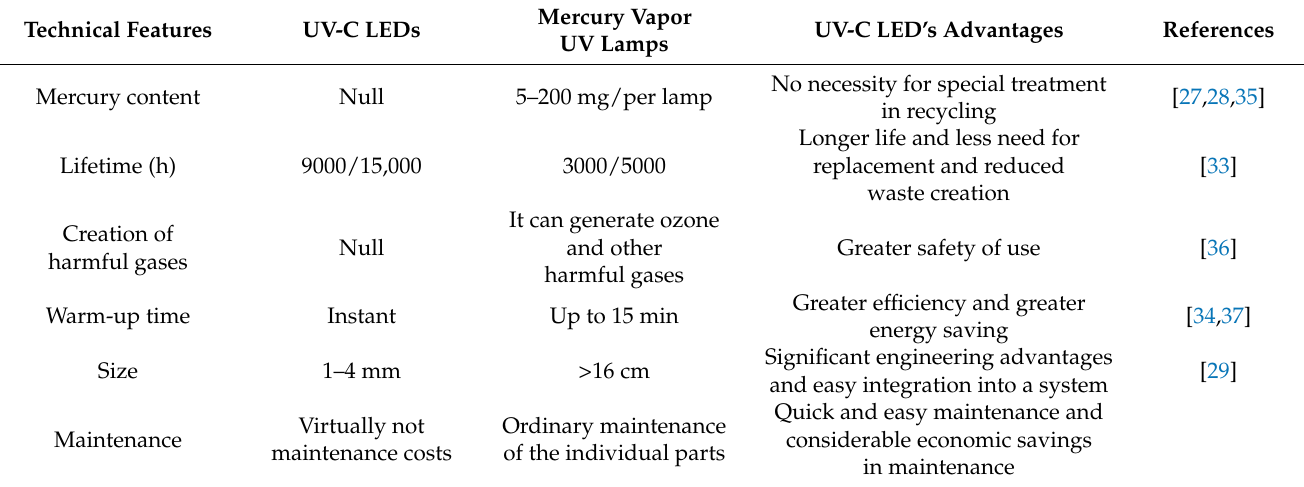
Table 1. Advantages and differences of UV-C LEDs compared to low-pressure mercury vapor UV